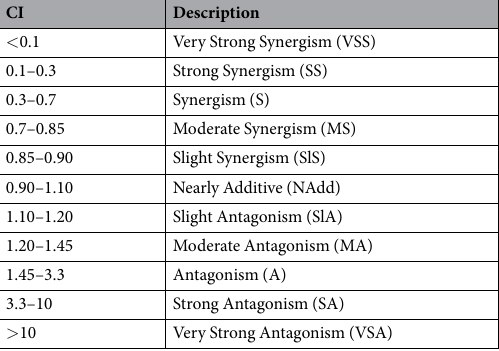
Table 1. Synergy assignment criteria based on Combination Index ranges.